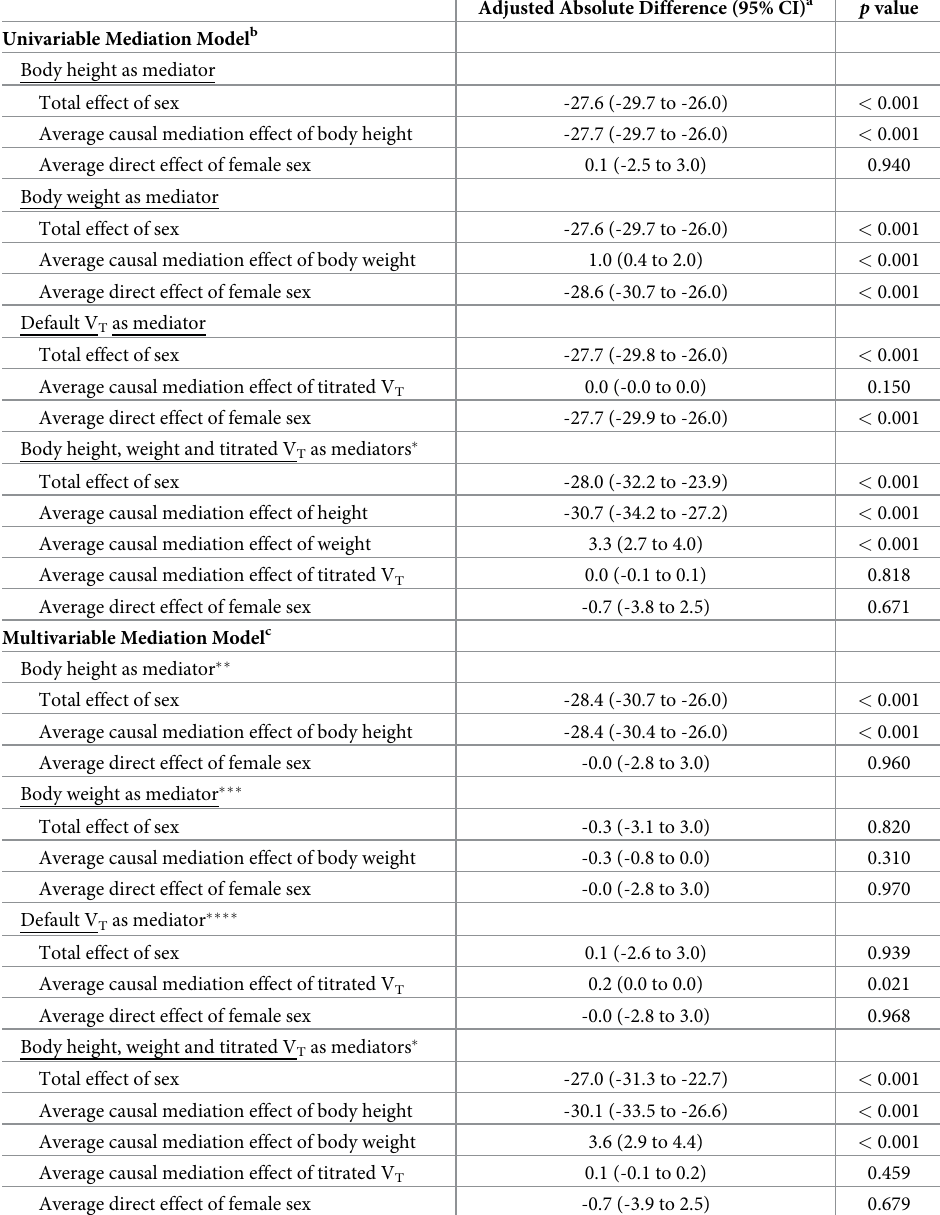
Table 3. Mediation